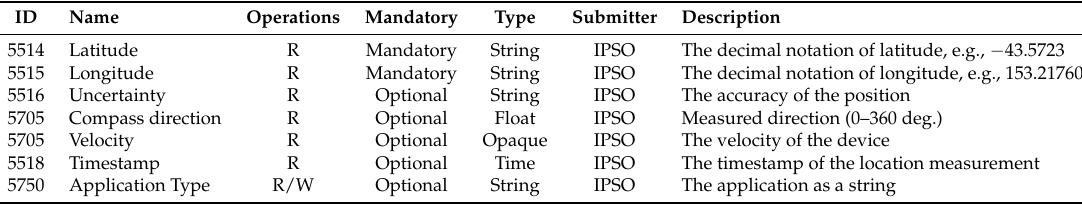
Table 2. IPSO location object for GPS data (Object ID 3336)